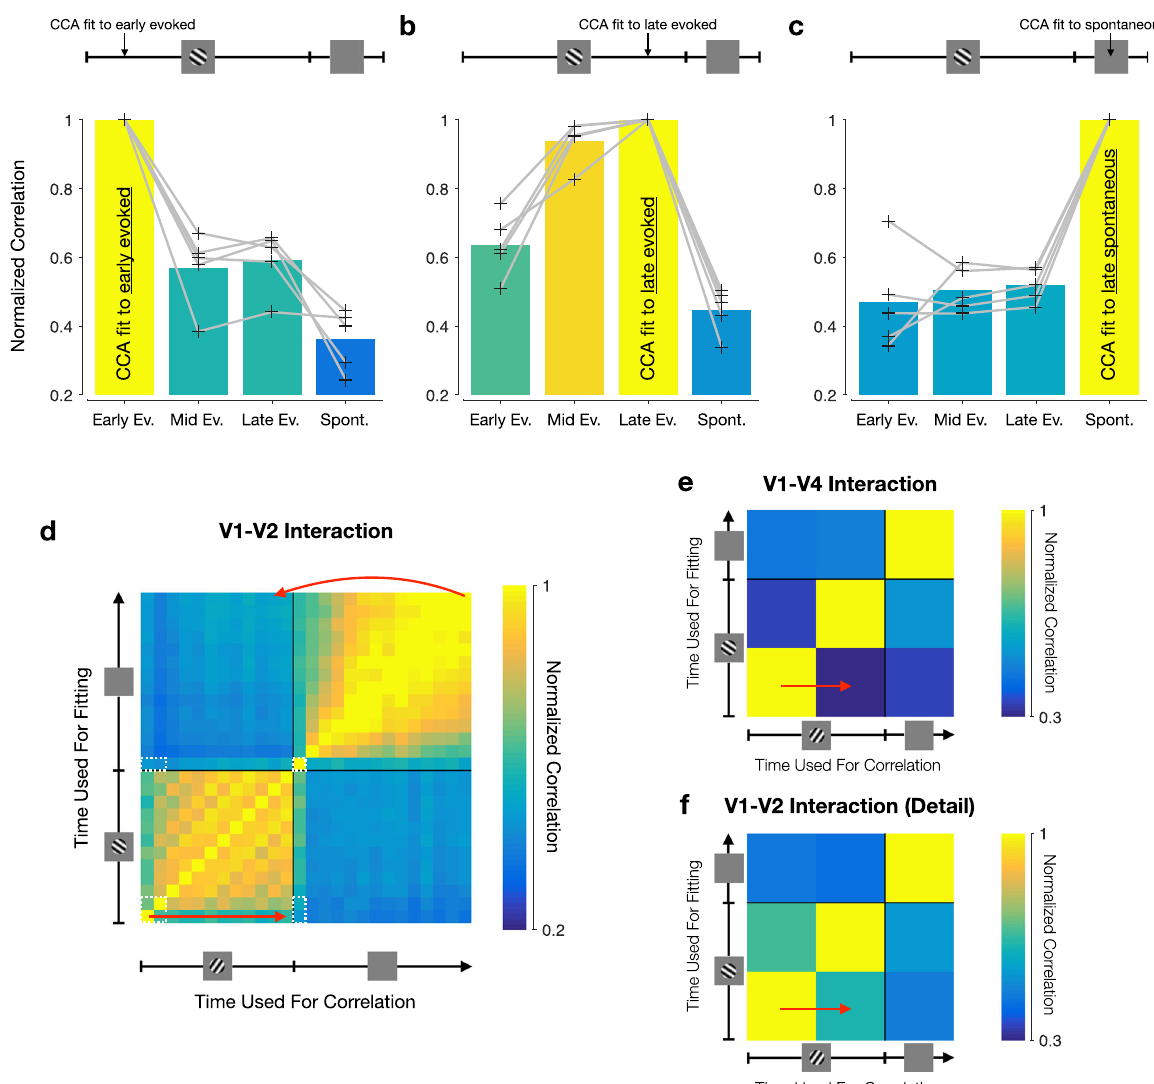
Fig. 6 Interaction structure is distinct for the feedforward- and feedback-dominated periods. a The dimensions found by fi tting CCA shortly after stimulus onset (80 ms after stimulus onset) do not generalize well to later epochs in the evoked period, and worse still during the spontaneous period. Gray lines correspond to each of the 5 recording sessions. We report the normalized correlation, de fi ned as the total correlation captured at the test epoch by the dimensions fi t to some other epoch over the total correlation captured by the dimensions fi t the test epoch (both computed in a cross-validated manner; see Methods). b Dimensions identi fi ed late in the evoked period (1180 ms after stimulus onset) do not generalize well to early evoked epochs and to epochs in the spontaneous period, but generalize well to mid-evoked activity. Same conventions as in a . c Dimensions identi fi ed during the spontaneous period do not generalize well to the evoked period. Same conventions as in a . d Assessing changes in interaction structure across the entire trial. The trial was divided into 100 ms segments, and CCA was applied separately to the activity in each time window. The top two canonical pairs associated with each window were then used to capture inter-areal correlations in the other time windows (see Methods). Each row corresponds to the time during the trial during which the canonical dimensions were identi fi ed. Each column corresponds to the time during the trial where the population correlation is assessed. Each entry shows the average across all recording sessions. Straight arrow highlights the comparison of the interaction structure within the evoked period. Curved arrow highlights the comparison of the interactions structure between the spontaneous and the evoked periods. Dashed white boxes indicate epochs reproduced in f . e Comparing identi fi ed dimensions across epochs for the awake V1 – V4 recordings. The trial was divided into 100 ms segments, and CCA was applied separately to the activity in each time window. The top canonical pair associated with each window was then used to capture inter- areal correlations in the other time windows (see Methods). Arrow highlights the comparison of the interaction structure within the evoked period. Same conventions as in d . f Detailed view of the V1 – V2 generalization performance for the comparable epochs between the V1-V2 and V1-V4 recordings. Epochs are indicated by the dashed white boxes in d